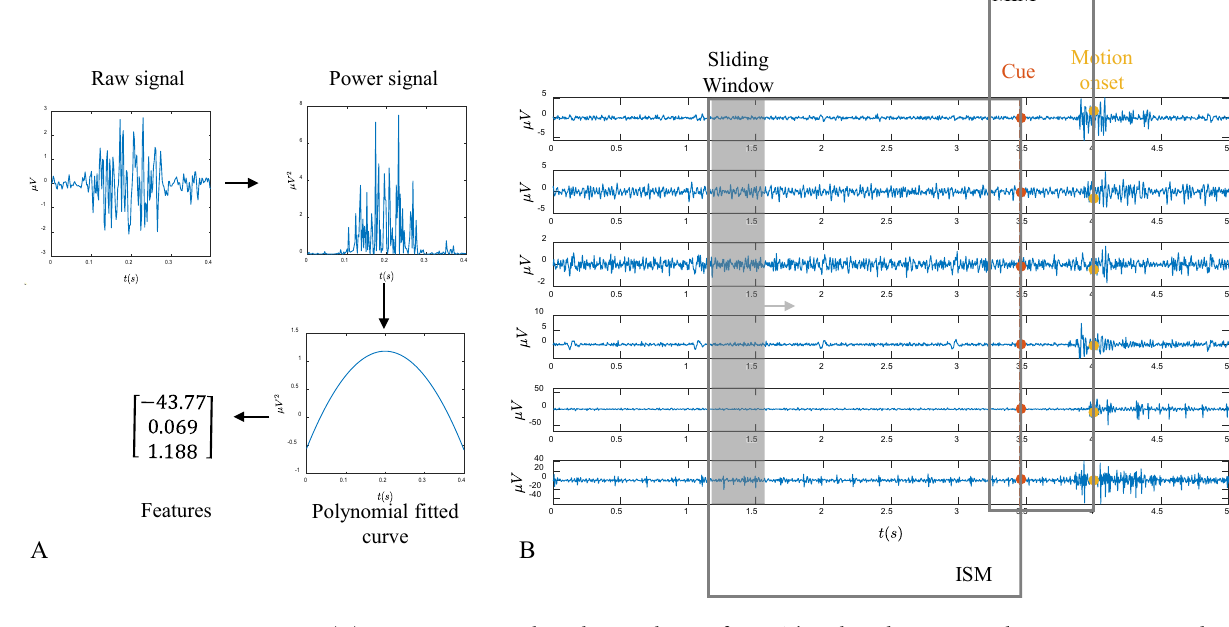
Figure 5. ( A ) Feature extraction by polynomial curve fitting. The selected sEMG signal segments are squared, smoothed and second-order polynomial fitted to obtain the three dimensional features. ( B ) Feature extraction for ISM and MIM. In idle state model(ISM), the signal 600ms before the cue point are used. Motion initiation model (MIM) focus on the signal from 100ms before the cue point to the motion onset point. A sliding window length of 20ms is used to extract